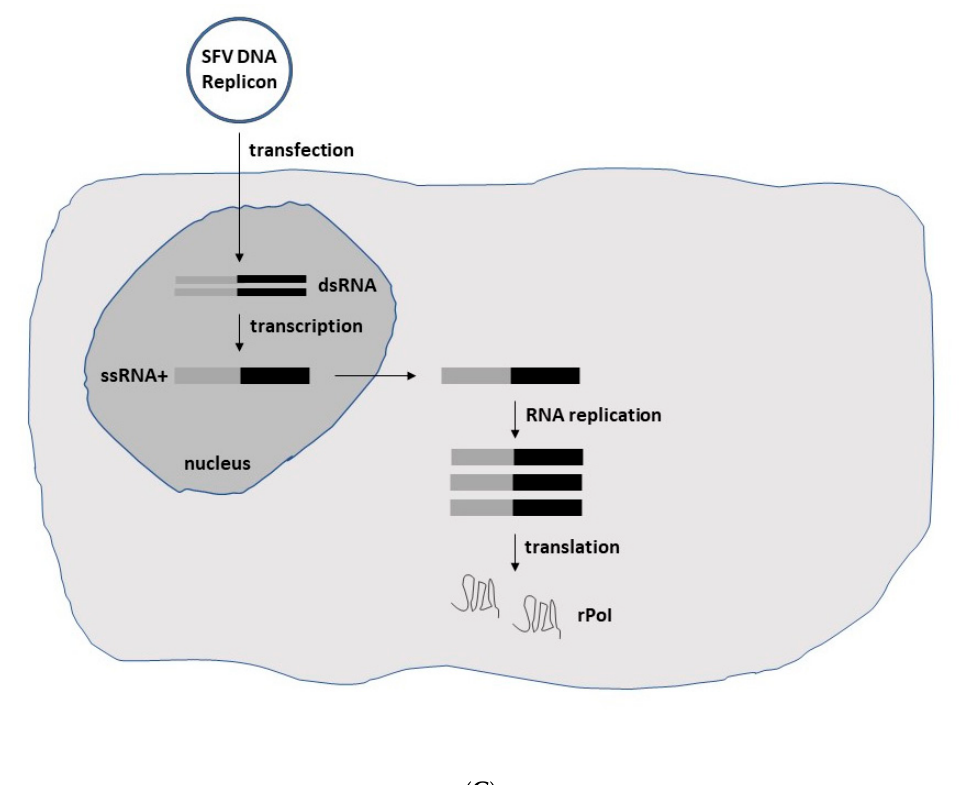
Figure 2. Schematic presentation of SFV expression systems. ( A ) Replication-deficient recombi- nant particles. In vitro transcribed RNA molecules from the SFV expression vector carrying the nonstructural protein (nsP) genes, replicase genes (replicon) and the gene of interest (GoI) and the structural protein genes (capsid, 6K, envelope E1, E2 and E3) from the helper vector are electro- porated or transfected into BHK-21 cells. After RNA replication, only the RNA from the expression vector containing the packaging signal is packaged into nucleocapsids and transported to the plasma membrane, where budding of mature viral particles takes place. Although the generated particles are capable of infecting new host cells, no viral progeny is produced due to the absence of the structural protein genes. However, high-level expression of the recombinant protein of interest (rPoI) takes place ( B ) Replication-competent recombinant particles. The in vitro transcribed full-length RNA genome with the GoI introduced either downstream of the nsP genes or the structural protein genes is electroporated or transfected into host cells for production of replication-competent viral particles and rPoI expression. ( C ) DNA replicon vectors. The replacement of the SP6 RNA polymerase promoter by a CMV promoter upstream of the nsP genes allows for direct transfection of host cells for rPoI expression. DNA replicons in the form of DNA plasmids are transfected into host cells, and DNA replicons are delivered to the nucleus. Transcribed ssRNA molecules of positive polarity are delivered to the cytoplasm for RNA replication and expression of the